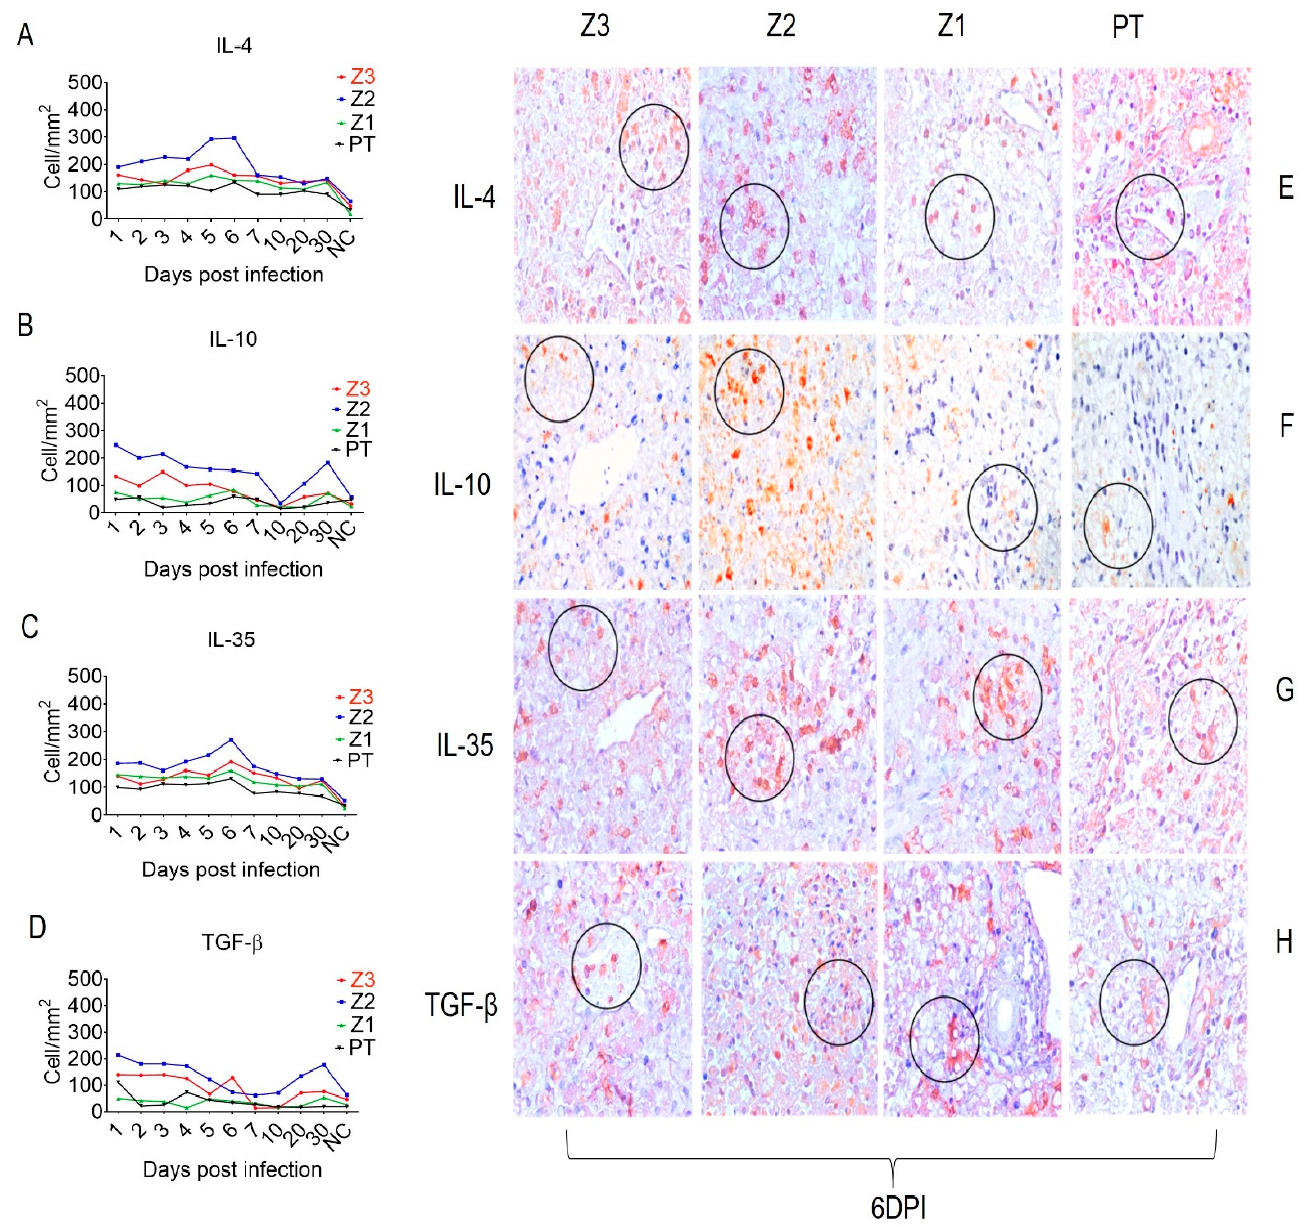
Figure 6. Quantitative immunohistochemical analysis of selected anti- inflammatory cytokines in zones Z3, Z2, Z1 and PT in hepatic parenchyma of squirrel monkeys ( Saimiri spp.) infected with YFV. Circles represent areas expressing higher immunostaining cells in different hepatic areas. ( A ) Expression of IL-4. ( E ) Immunostaining for IL-4 in hepatocytes (E-Z3), (E-Z2), (E-Z1) in inflamma- tory infiltrate area (E-PT). ( B ) Expression of IL-10. ( F ) Immunostaining for IL-10 in hepatocytes (F-Z3), (F-Z2), (F-Z1), (F-PT). ( C ) Expression of IL-35. ( G ) Immunostaining for IL-35 in hepatocytes in all examined hepatic tissues (G-Z3), (G-Z2), (G-Z1), (G-PT). ( D ) Expression of TGF- β . ( H ) Im- munostaining for TGF- β in the inflammatory infiltrate (H-Z3), (H-Z2), and in hepatocytes (H-Z1), (H-PT) 6 dpi.